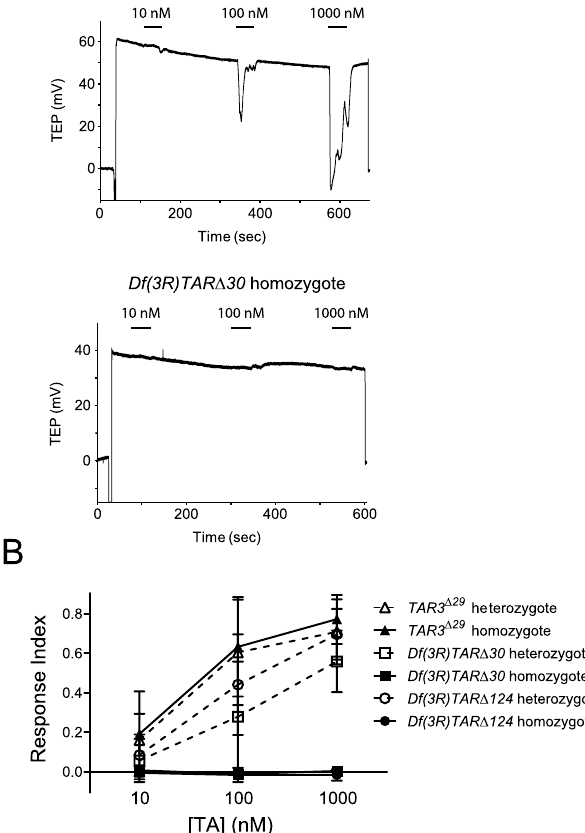
Figure 3. Response of TAR deletion mutants to TA. ( A ) Representative traces showing the response to 1000 nM TA of a Df ( 3R ) TAR Δ 30 heterozygote (upper trace) and homozygote (lower trace). ( B ) Dose-response curve to TA for TAR3 Δ 29 , Df ( 3R ) TAR Δ 30 , and Df ( 3R ) TAR Δ 124 heteroyzygotes and homozygotes. The mean responses of Df ( 3R ) TAR Δ 30 , and Df ( 3R ) TAR Δ 124 homozygotes to each concentration of TA were either not